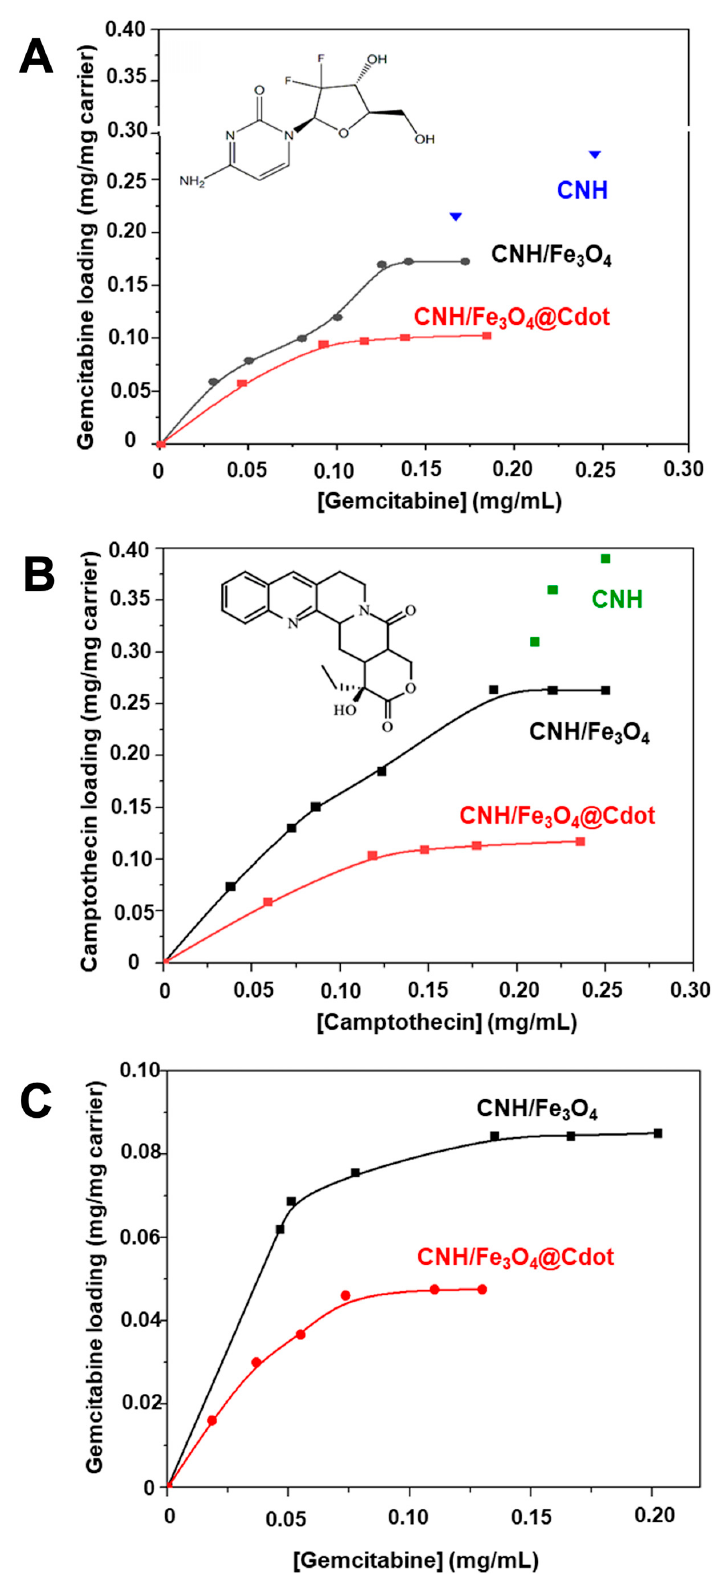
Figure 7. ( A ) GEM and ( B ) CPT-loading on CNH, CNH/Fe 3 O 4 , and CNH/Fe 3 O 4 @Cdot carriers. ( C ) GEM-loading on CNH/Fe 3 O 4 and CNH/Fe 3 O 4 @Cdot after half-saturated loading of CPT.